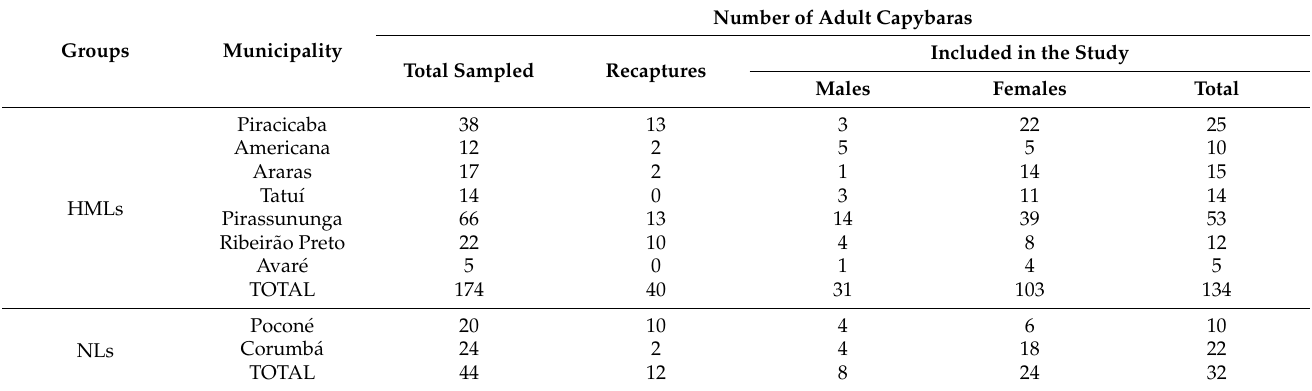
Table 2. Number of adult capybaras sampled by locality of human-modified landscapes (HMLs) and natural landscapes (NLs) in Brazil.